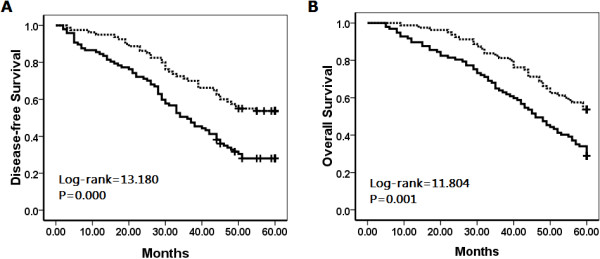
Kaplan–Meier analysis of cervical SCC patient survival rates in relation to NQO1 protein expression. Disease-free survival (A) and overall survival rates (B) of patients with elevated (solid, n = 97) and low (dashed, n = 80) NQO1 expression.